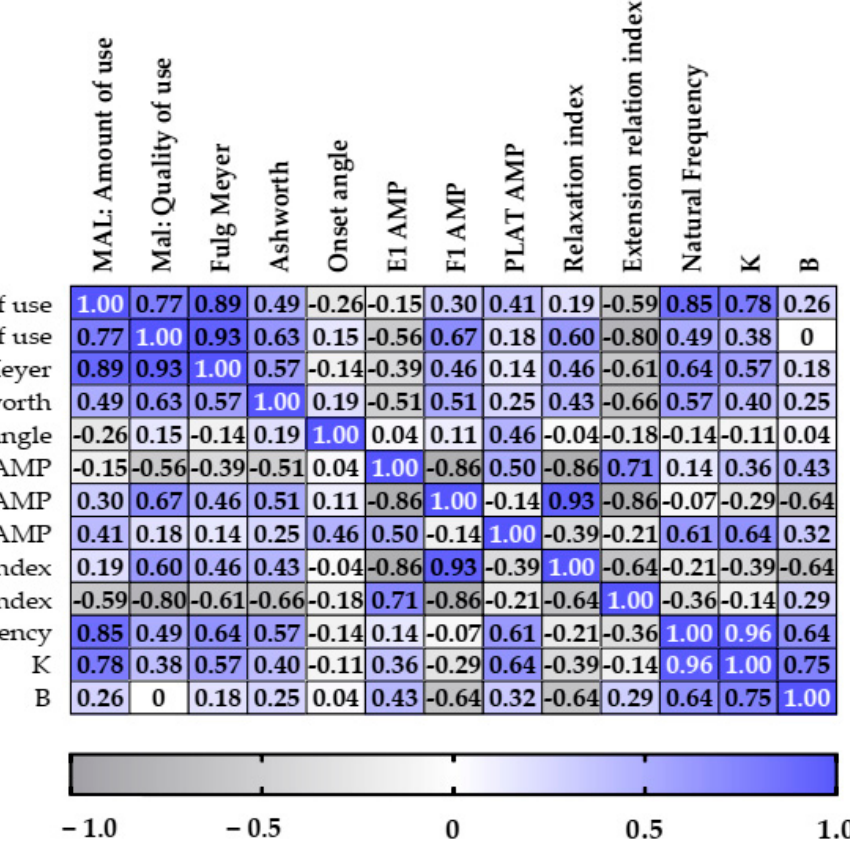
Figure 4. Correlation data of the clinical scales and the variables evaluated in the pendulum test with the inertial sensor according to Spearman’s correlation. The results are represented by color value gradients (the darker the color, the greater the correlation).